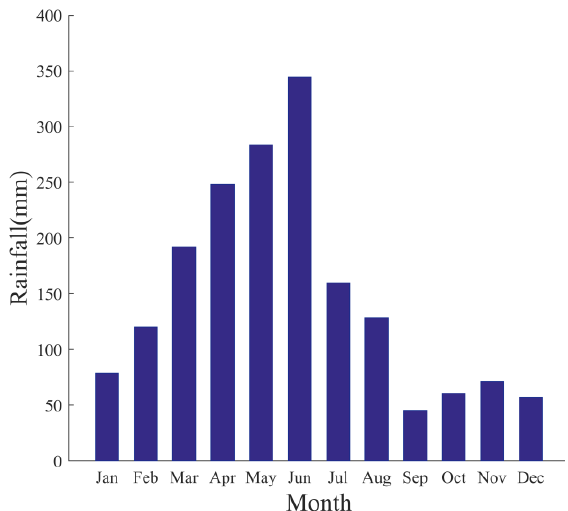
Figure 2. Diagram showing the average monthly rainfall in the study area.